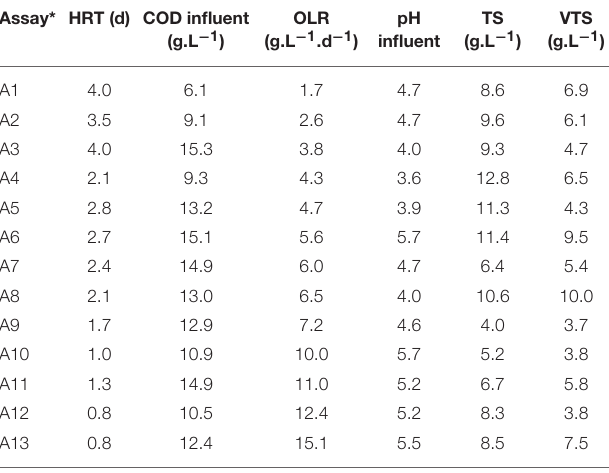
TABLE 1 | Operating conditions of R1 and R2